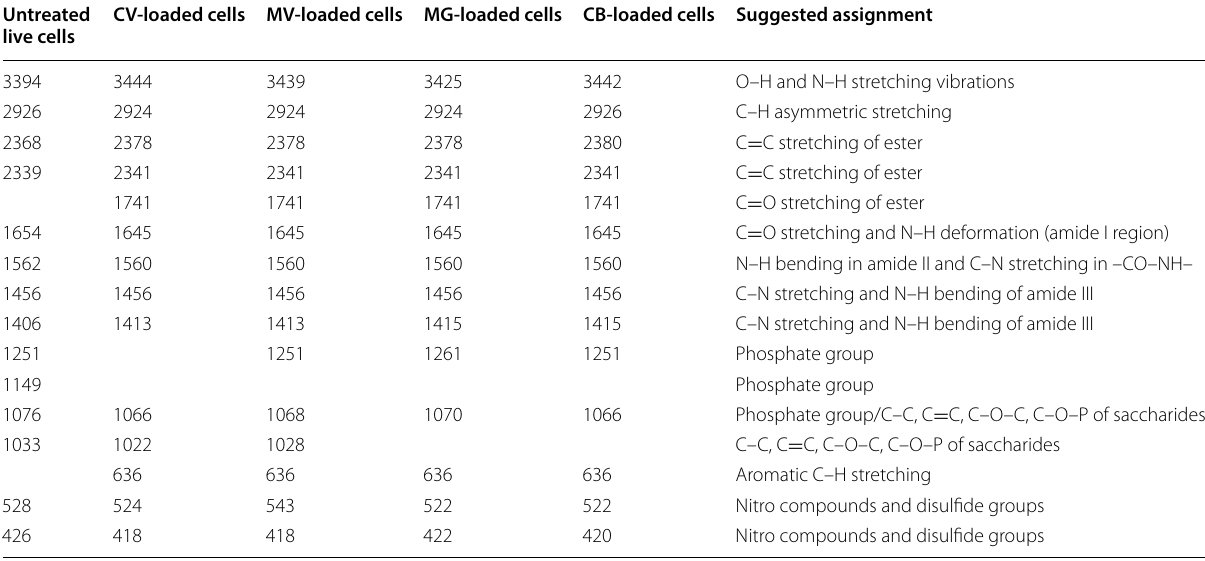
Table 1 Exemplary FTIR band positions (cm-1) of live cells of isolate SWUSI4 before and after treatment with CV, MV, MG and CB Untreated live cells